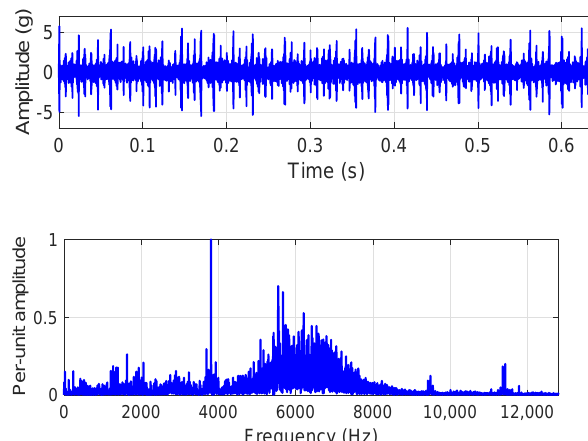
Figure 3. ( top ) Vibration signal acquired from the generator bearing, ( bottom ) spectrum.